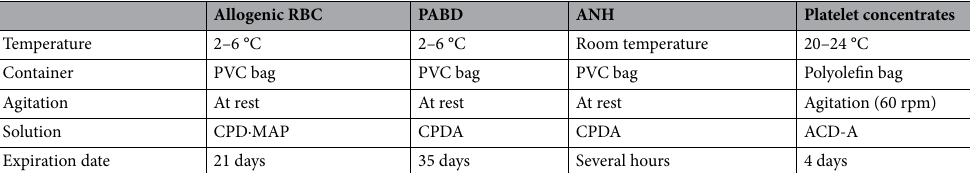
Table 1. Blood storage conditions and expiration dates. Blood storage conditions and expiration dates vary by country and facility. This table refers to some guidelines and our practice 1,15–23 . RBC red blood cell, PABD preoperative autologous blood donation, CPD-MAP citrate–phosphate–dextrose∙mannitol–adenine– phosphate, CPDA citrate–phosphate–dextrose–adenine, ACD-A acid-citrate-dextrose formula